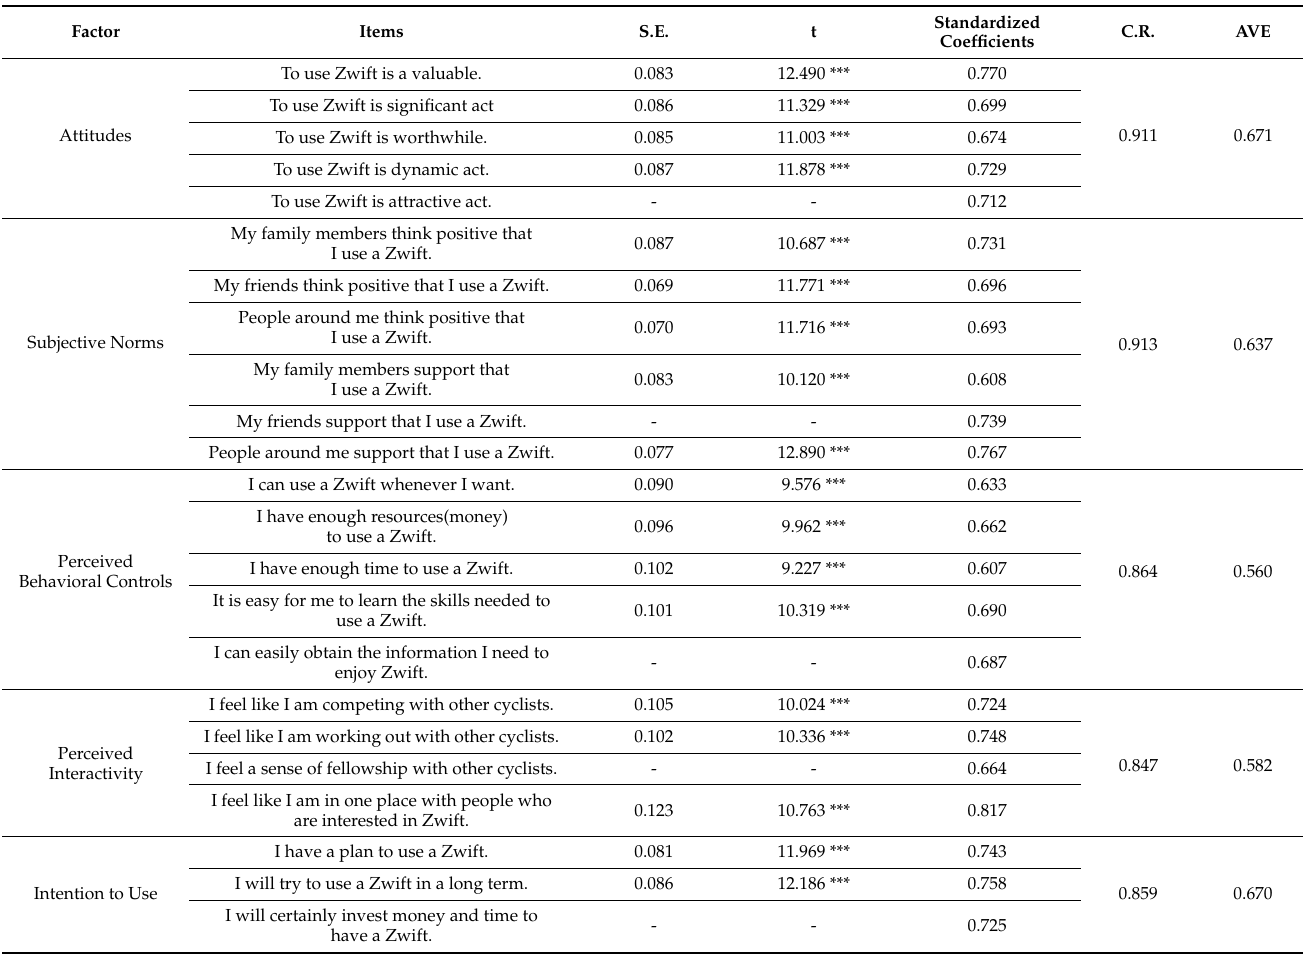
Table 2. Results of confirmatory factor analysis.